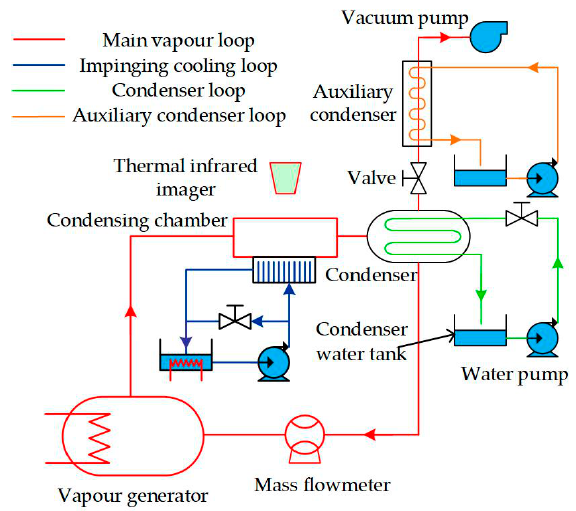
Figure 1. Schematic diagram of the experimental apparatus.